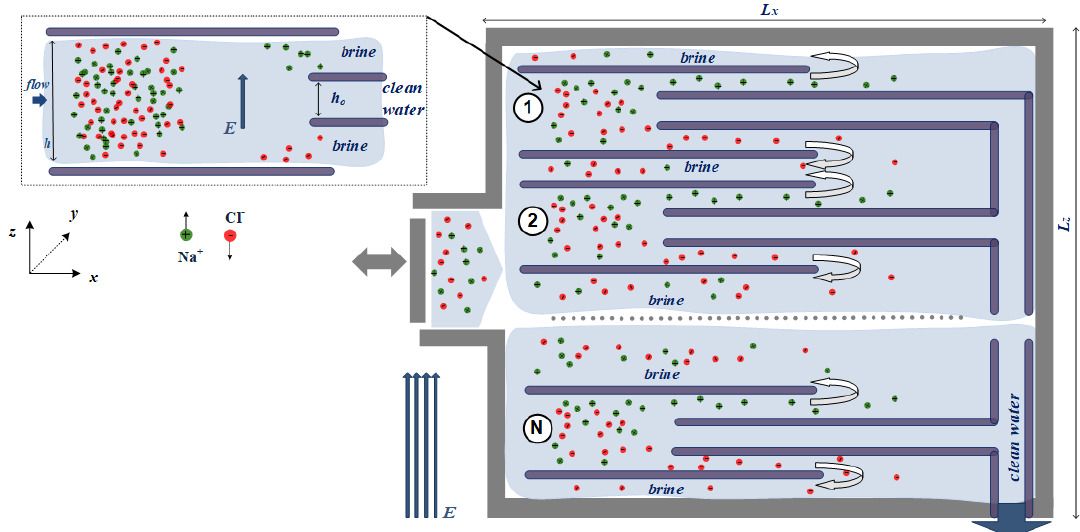
Figure 1. The proposed desalination device, consisted by an array of N cells. The inset figure presents a detailed view of each cell. Green and red circles are Na + and Cl − ions, respectively. The external electric field E z is applied perpendicular to the piston-driven flow. Clean water is gathered from each cell to the common outlet, while the remaining water/ion solution (brine) is recirculated to further separate water from ions.